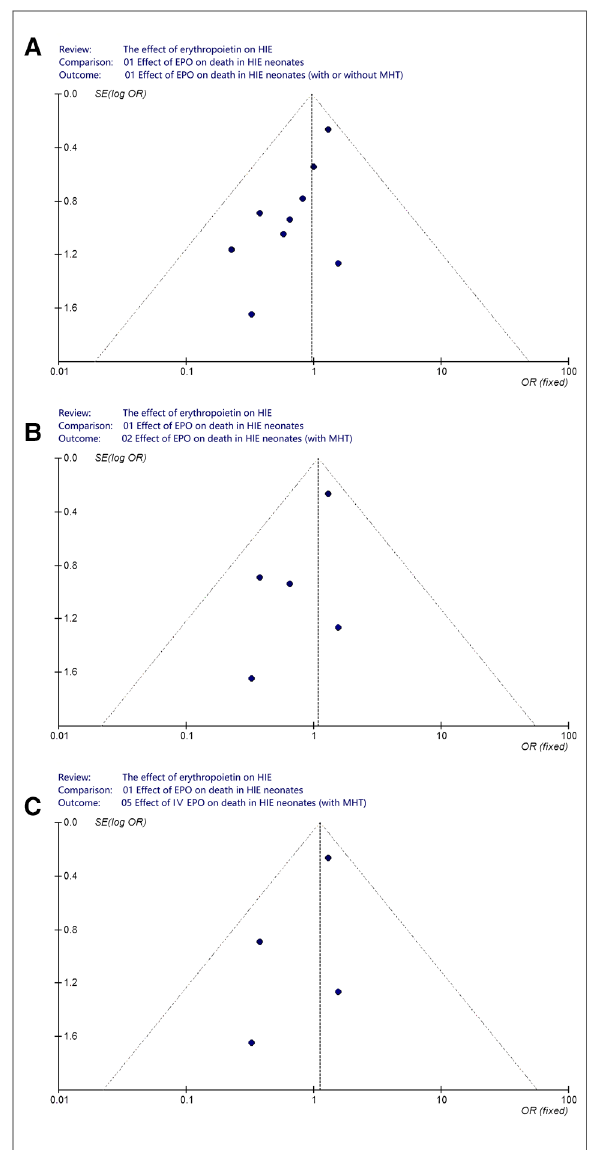
FIGURE 8 Funnel plot to assess publication bias. ( A ) Effect of EPO on death in HIE neonates (with or without MHT); ( B ) Effect of EPO on death in HIE neonates (with MHT); ( C ) Effect of IV EPO on death in HIE neonates (with